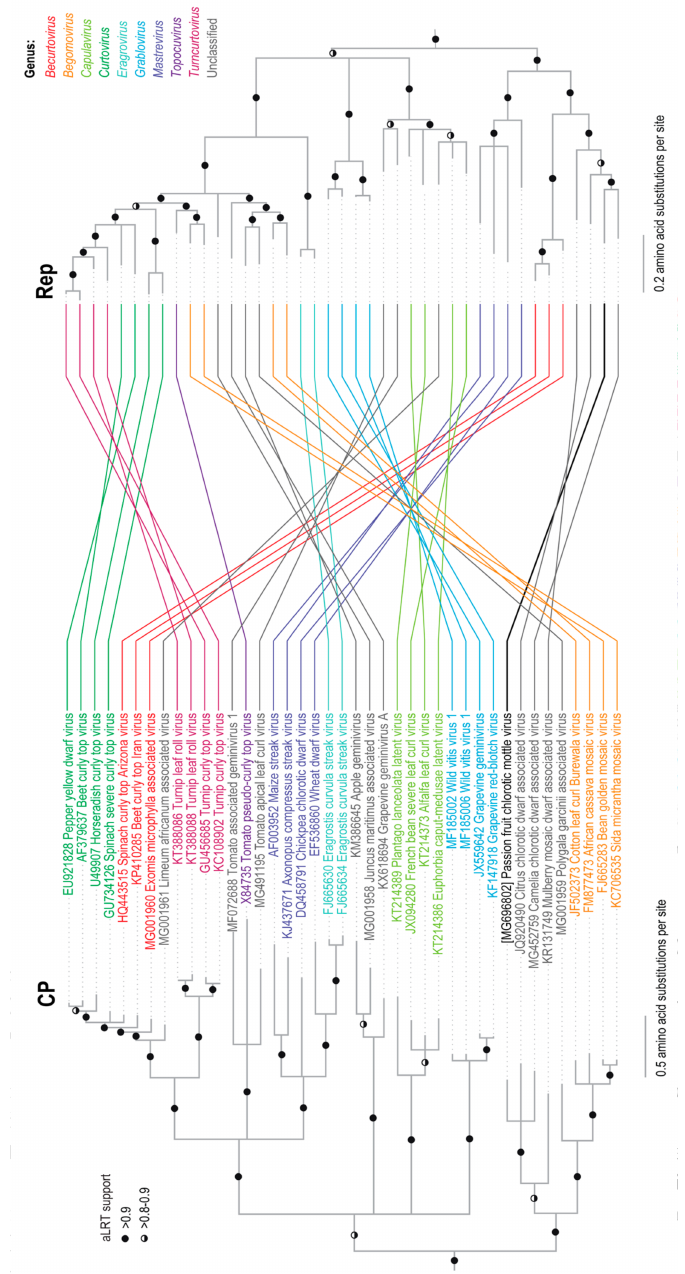
Figure 2. Maximum likelihood phylogenetic tree inferred using the substitution models rtREV+G+I+F and rtREV+G+I for capsid protein (CP) and Rep amino acid sequences, respectively, with an approximate likelihood ratio test (aLRT) for branch support of representative geminiviruses and PCMoV identified in this study. Both trees are rooted with the CP and Rep amino acid sequences of the genomovirus, Sclerotinia sclerotiorum hypovirulence associated DNA virus 1 (KM598384) and MSSI2.225 virus (LK931485). Branches with <0.8 aLRT branch support have been